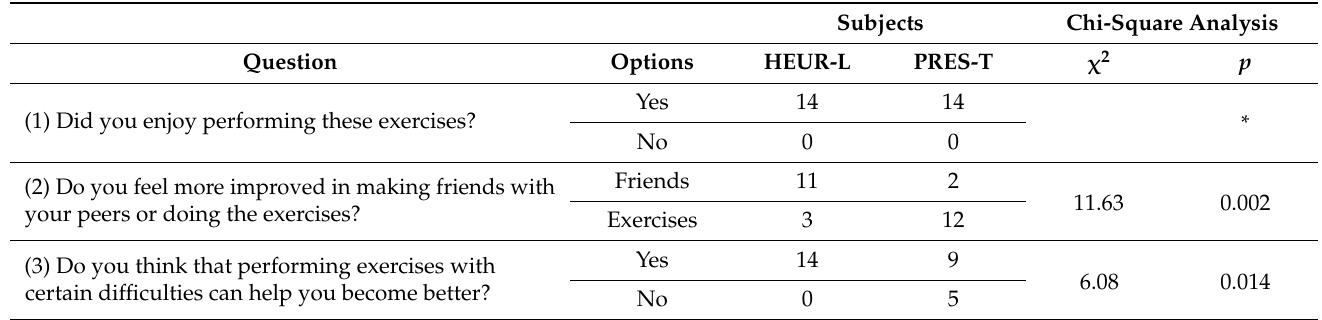
Table 3. Differences in perceptions of the activity performed between HEUR-L and PRES-T.